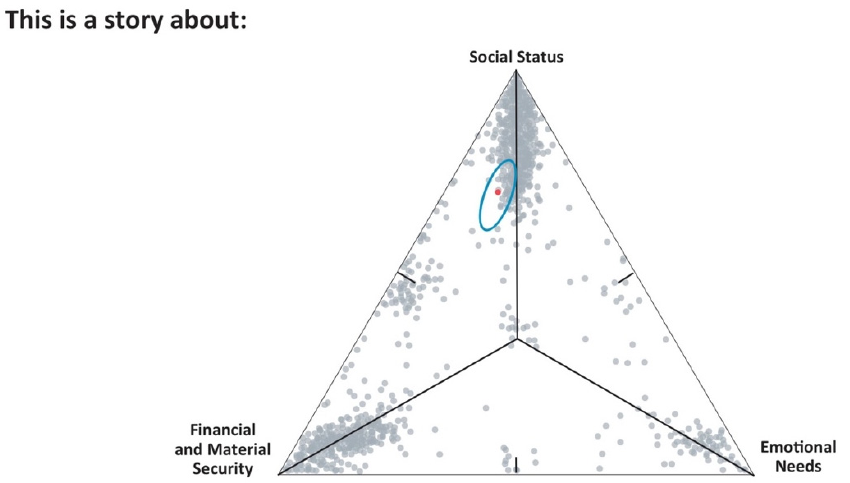
Figure 1. Geometric mean for Triad 1: This Story is about: (i) financial and material security; (ii) social status; (iii) emotional needs.